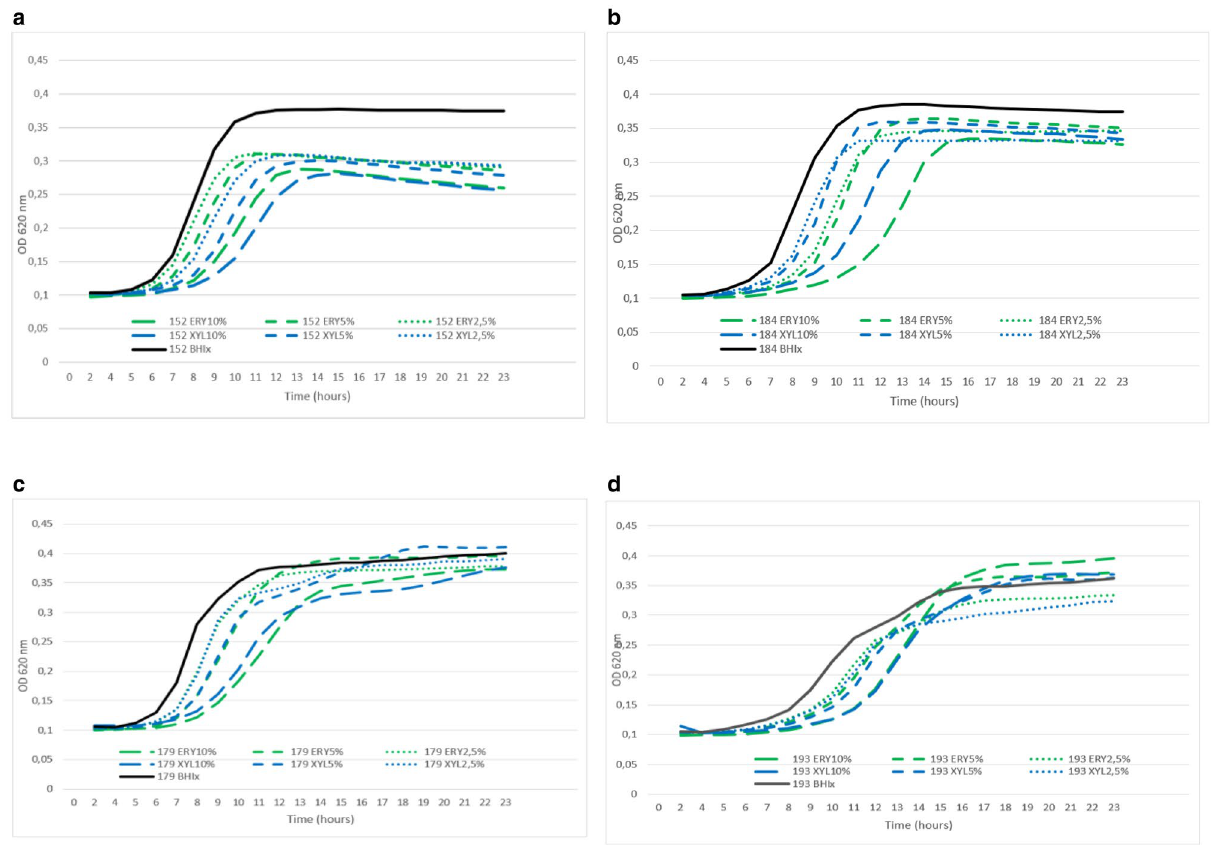
pyogenes 179, ( d ) S. pyogenes